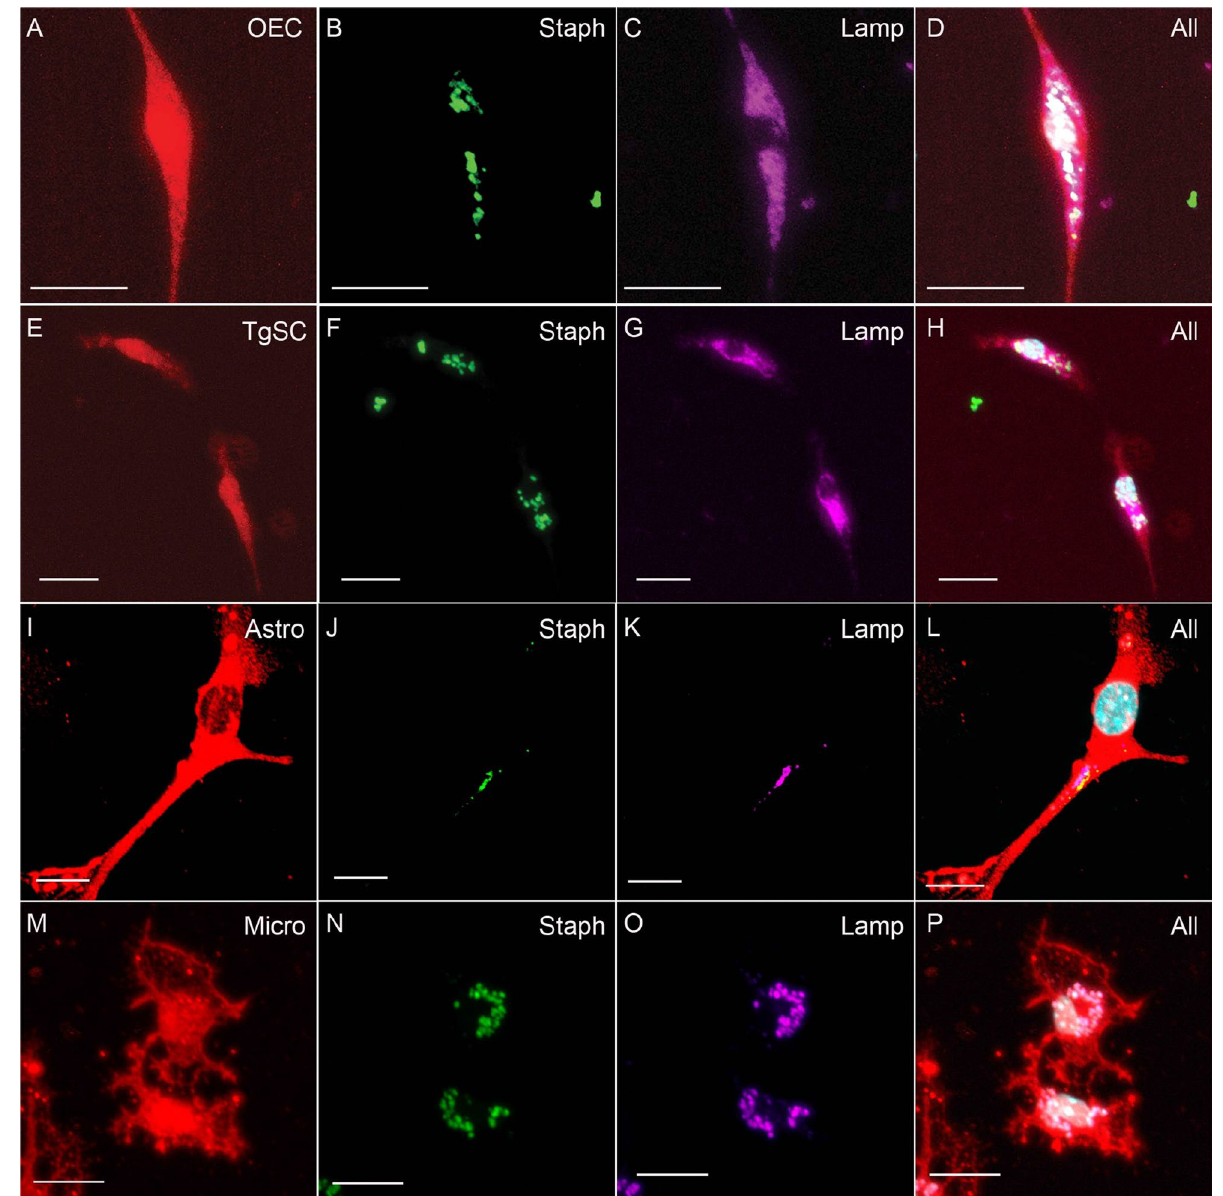
Figure 3. Phagocytosis of S. aureus in phagolysosomes in different glial cells. Panels show primary cultures of OECs ( A – D ), TgSCs ( E – H ), astrocytes ( I – L ) and microglia ( M – P ) from S100β-DsRed mice. For OECs and TgSCs, red labelling shows DsRed; for astrocytes, red labelling shows GFAP (these cells express low levels of DsRed); for microglia, red labelling shows Iba-1 and Hoechst for nucleus staining. ( B , F , J , N ) shows S. aureus within cells, ( C , G , K , O ) LAMP-2 stain for lysosomes. S. aureus colocalizes with LAMP-2 stains showing the bacteria is internalized in phagolysosomes. Scale bar: 20 interferon γ (IFN-γ) and tumour necrosis factor α (TNF-α), with levels of IFN-γ being high in microglia than TNF-α and lower than those for OECs; TgSCs and astrocytes (Fig. 5A–H). The cells also responded to S. aureus with secretion of interleukin 6 (IL-6), and the anti-inflammatory and immune-regulatory cytokine interleukin 10 (IL-10). The amount of IL-6 was consistently higher than the amount of IL-10 (Fig. 5) in OECs, TgSCs and astrocytes; in contrast microglia expressed higher IL-10 than IL-6. Microglia produced significantly higher levels of IFN-γ and IL-10, TgSCs showed significantly higher levels of TNF-α and IL-6, than the other glial types, with some variations between time-points (Fig. 5 and Table 1). Overall, production of TNF-α by OECs, TgSCs and astrocytes peaked at 6 h post exposure and for microglia at 1 h. The levels of IFN-γ and IL-10 were highest at 1 h for microglia as compared to OECs, TgSCs and astrocytes and continued till 24 h. Whilst the levels of IFN-γ, IL-6 and IL-10 were highest at 24 h for OECs, TgSCs and astrocytes. The glia also produced chemokines, including high levels of CXCL1, monocyte chemoattractant protein 1 (MCP-1), macrophage inflammatory proteins 1α and β (MIP-1α, MIP-1β), regulated upon activation—normal